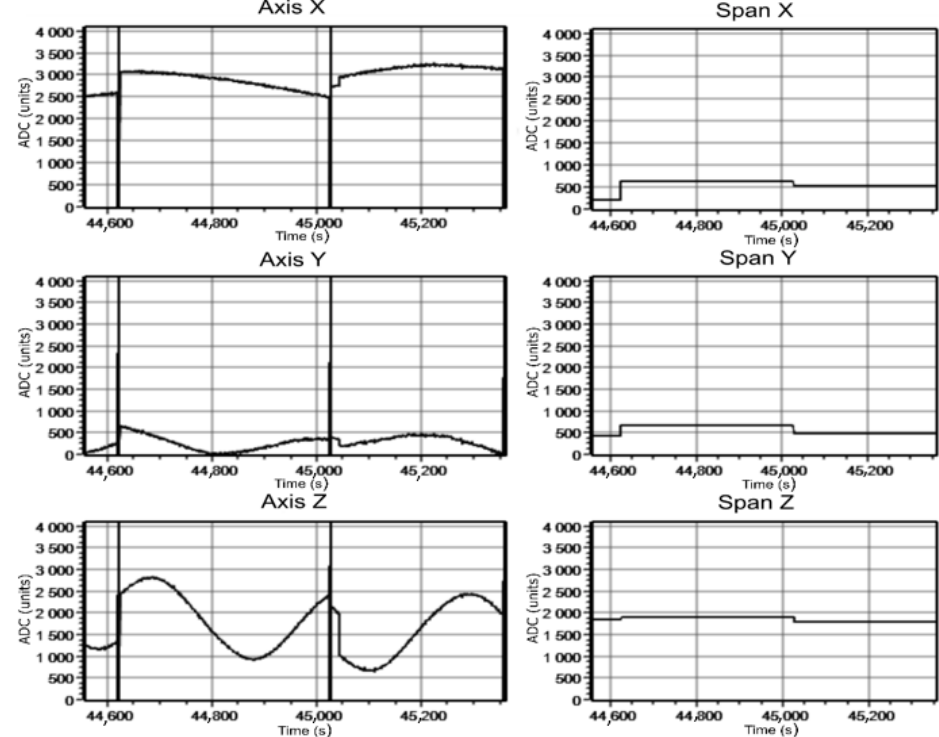
Figure 18. Magnetic induction signals at 295 A current in a cable.